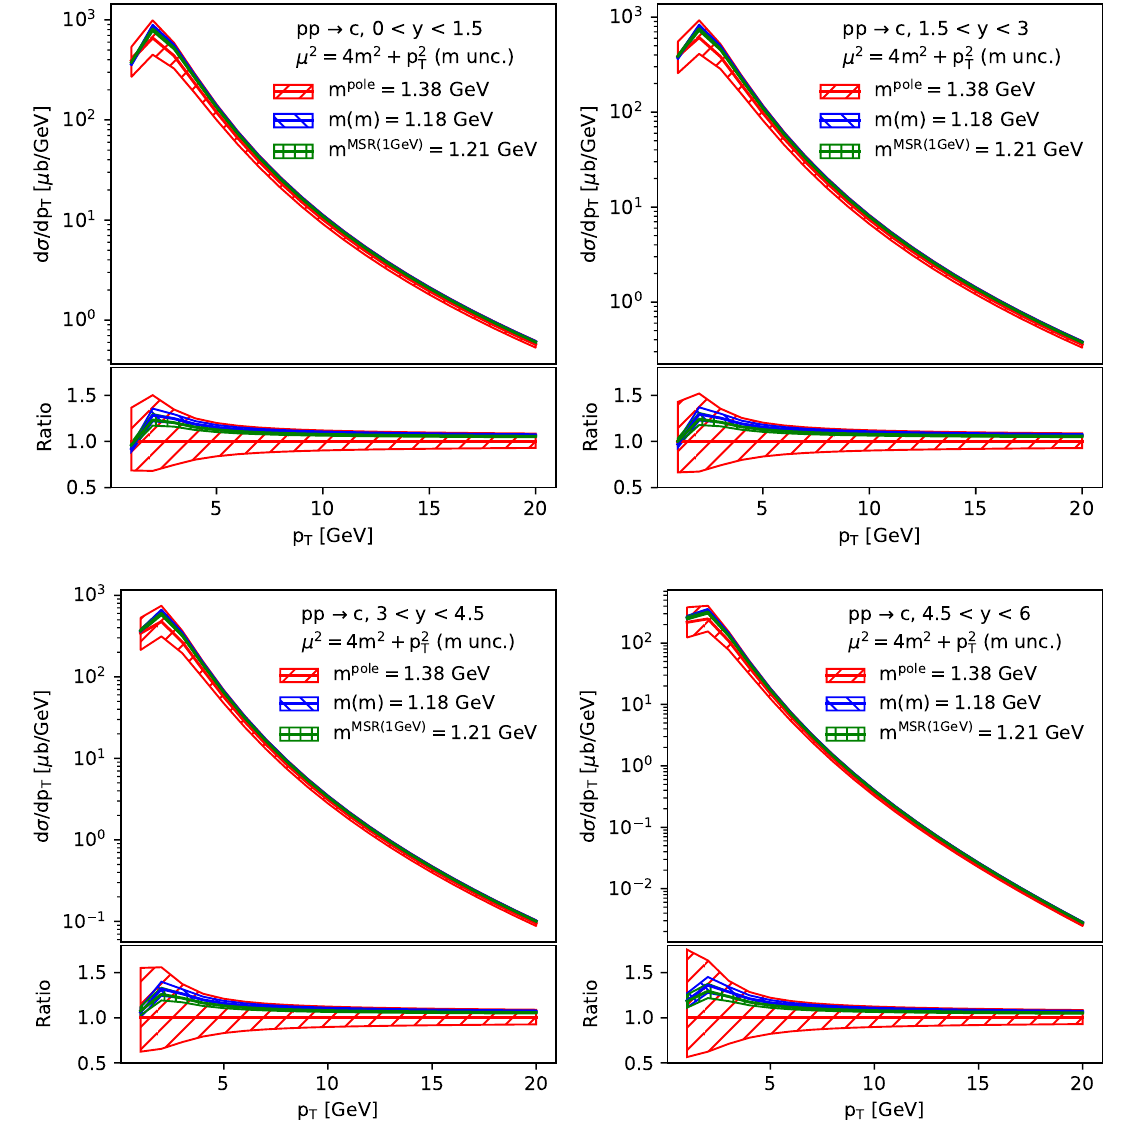
Figure 9 . Same as figure 8, but for the charm-mass value m c ( m c ) = 1.18 ± 0.03 GeV (converted to m MSR (1 GeV) = 1.21 ± 0.03 GeV and m pole c NLO